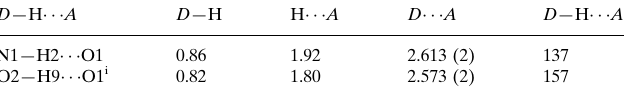
Hydrogen-bond geometry (A˚ , (cid:1)